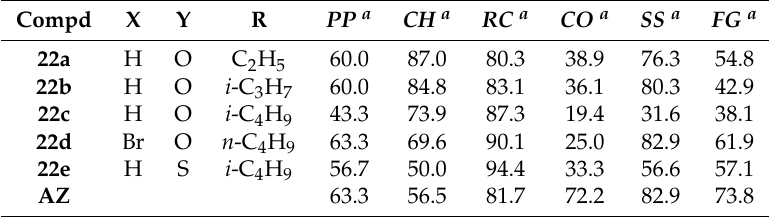
Table 2. Fungicidal activity (growth inhibition rate, %) of compounds 22a – e at 50 mg / L in vitro from Reference [17].